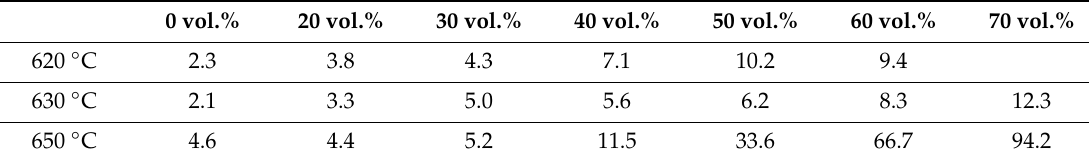
Table 2. Degree of nitridation of the 0–70 vol% SiC (20 µ m)/6061Al composites heated at 620–650 °C for 1 h.